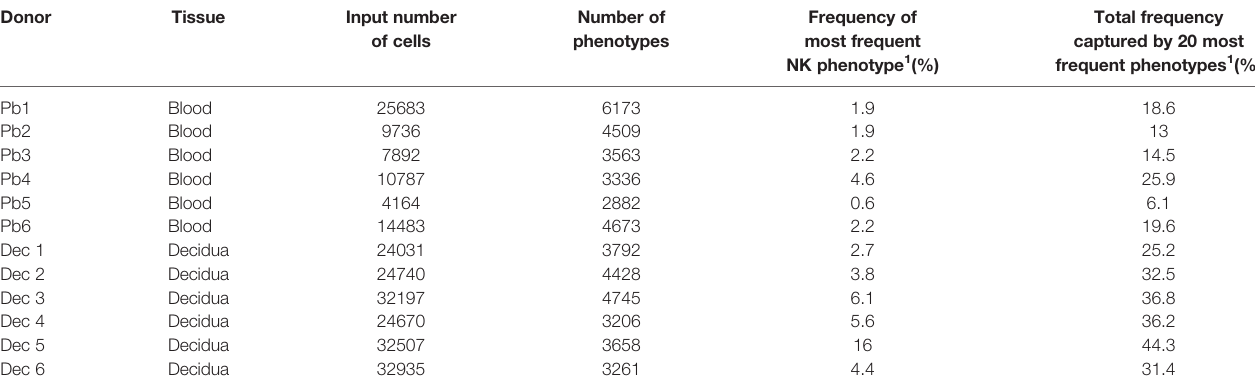
TABLE 1 | Phenotypic diversity of CD45+Lin − CD56+ cells in human blood and decidua based on receptor pro fi les of individual cells analysed by mass cytometry. Donor